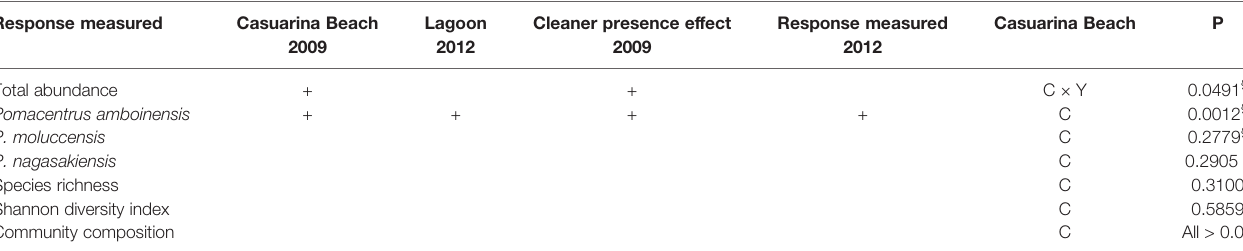
TABLE 1 | Summary of results for fi sh abundance, diversity, and community composition in relation to the effect of cleaner fi sh Labroides dimidiatus treatment (presence or absence) reef -1 and or their interactions with other factors ( Supplementary Tables 4, 5 ). Response